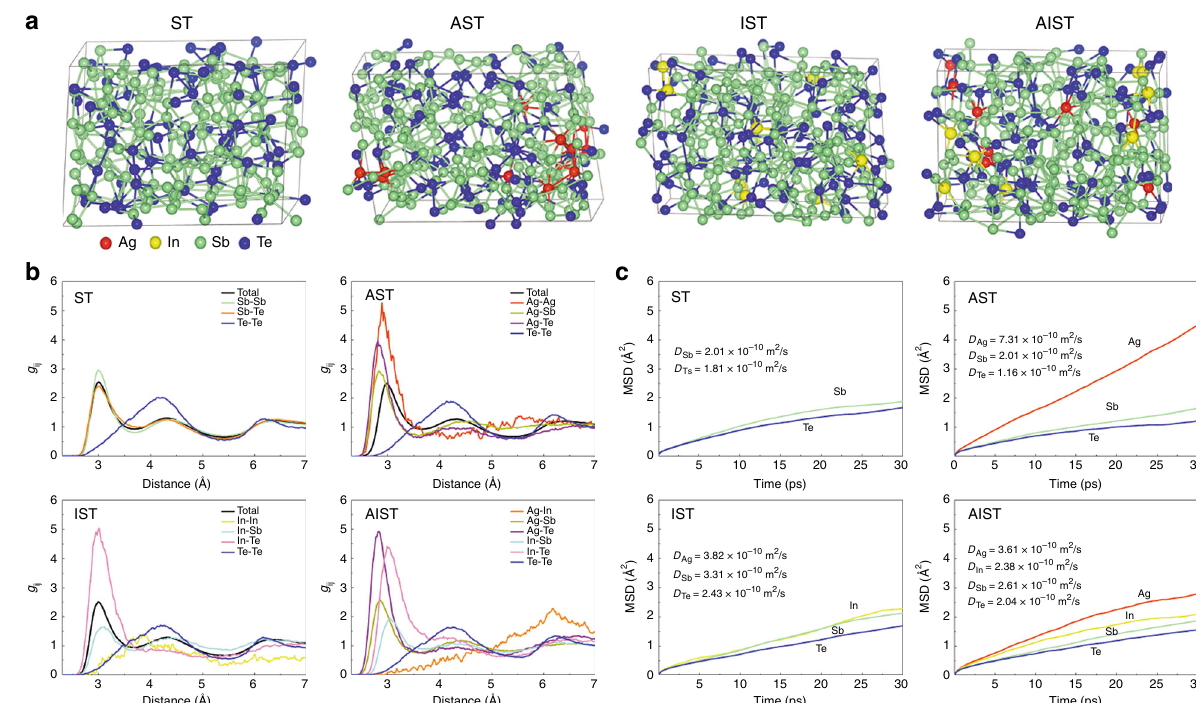
Fig. 5 The structural and kinetic features of Sb 128 Te 48 , Ag 8 Sb 128 Te 48 , In 8 Sb 128 Te 48 , and Ag 8 In 8 Sb 128 Te 48 systems at 600 K. a snapshots of the last frames of these systems relaxed at 600 K. b partial PDFs of these systems. c mean-square displacement (MSD) of these systems